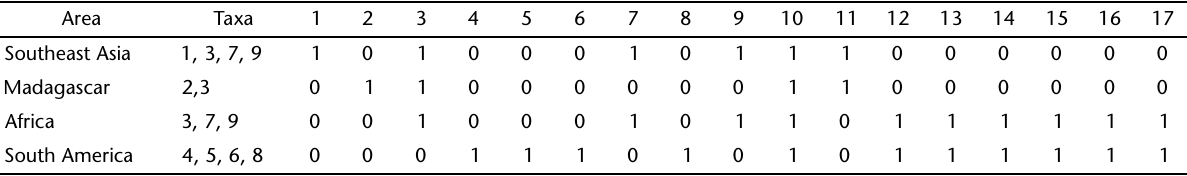
Table I. Matrix listing the geographical distribution of cuckoos subfamilies, along with the binary codes representing the phylogenetic relationships among the subfamilies. Area